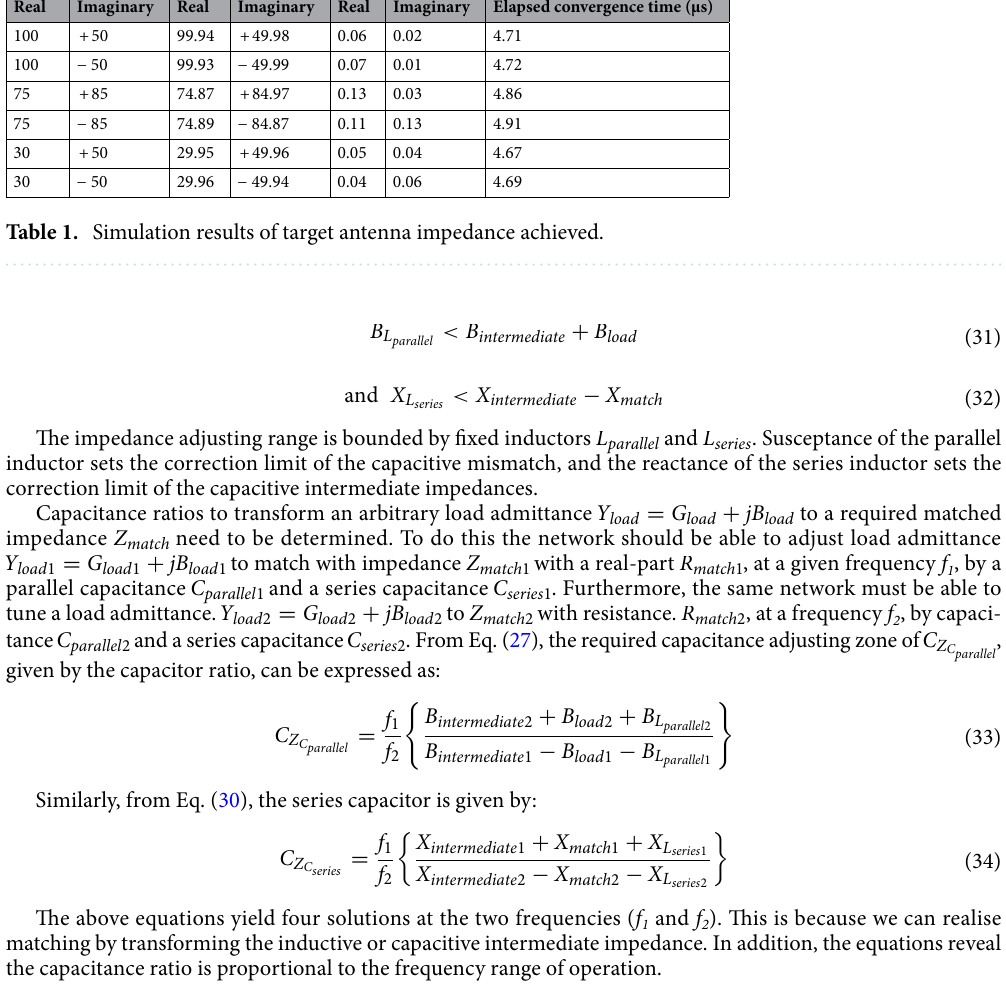
Target antenna impedance (Ω)